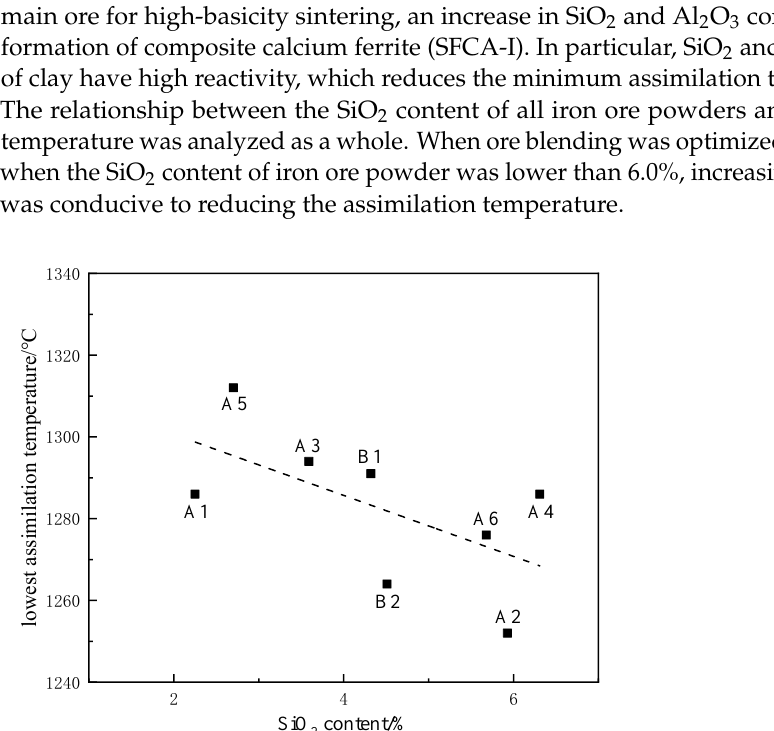
Figure 7. Influence of SiO 2 content on assimilation temperature.